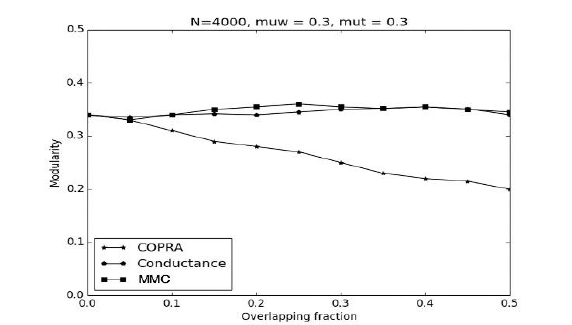
Figure 5. Modularity of the community structure detected by COPRA, Conductance and MMC while N =4000 and muw=mut